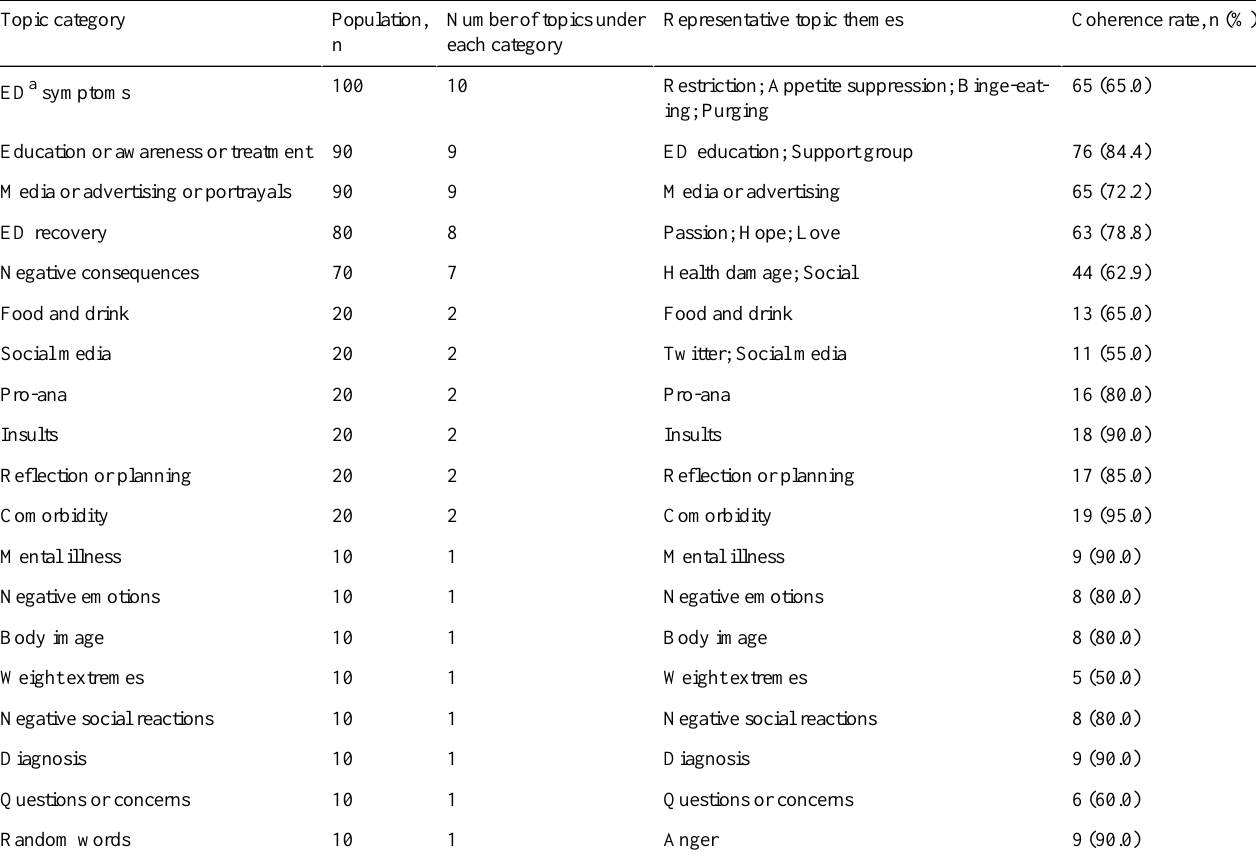
Table 3. A summary of the topics using group 2 tweets (ie, ED-laypeople tweets identified by the developed